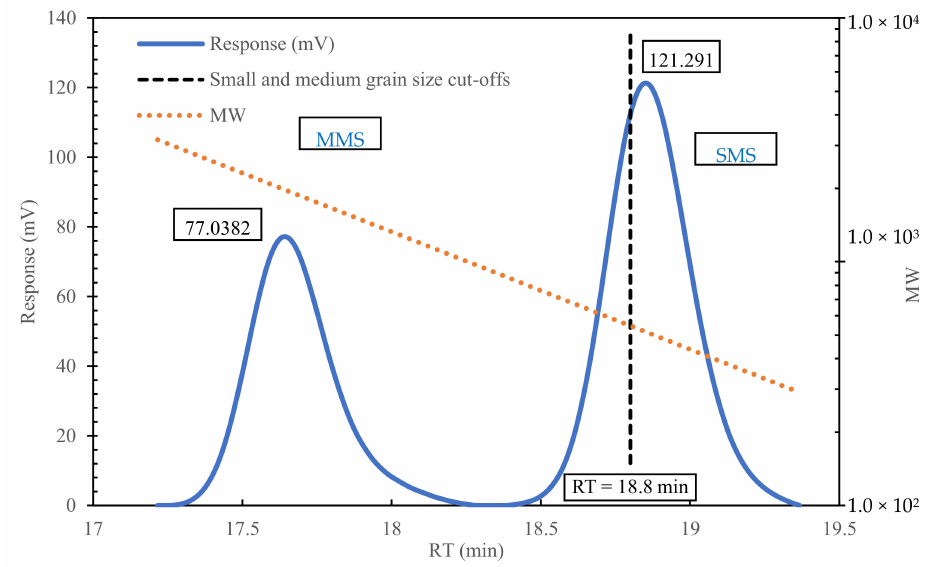
Figure 2. Gel permeation chromatography (GPC) analysis diagram of BRA.